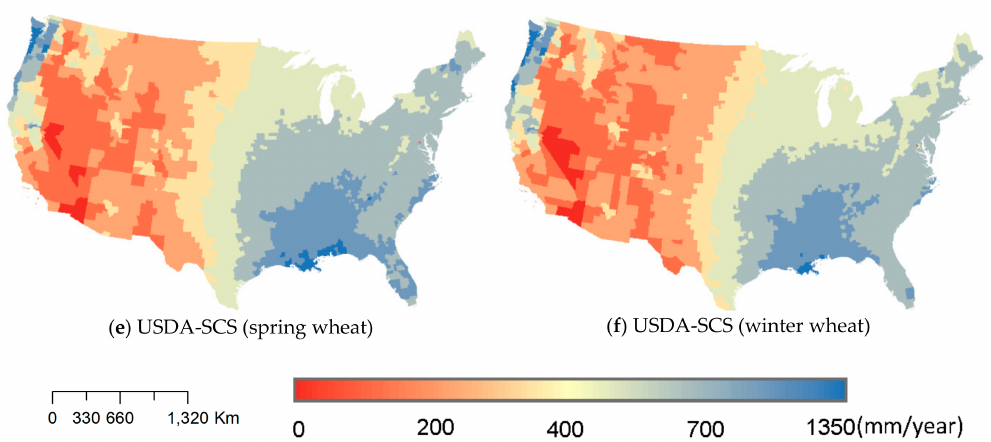
Figure 4. 30-year (1971–2000) average annual green water resources (mm/year) estimated using ( a ) the Smith method, ( b ) the NHDPlus V2 dataset, and the USDA-Soil Conservation Service (SCS) methods based on crop evapotranspiration of ( c ) corn, ( d ) soybeans, ( e ) spring wheat, and ( f ) winter